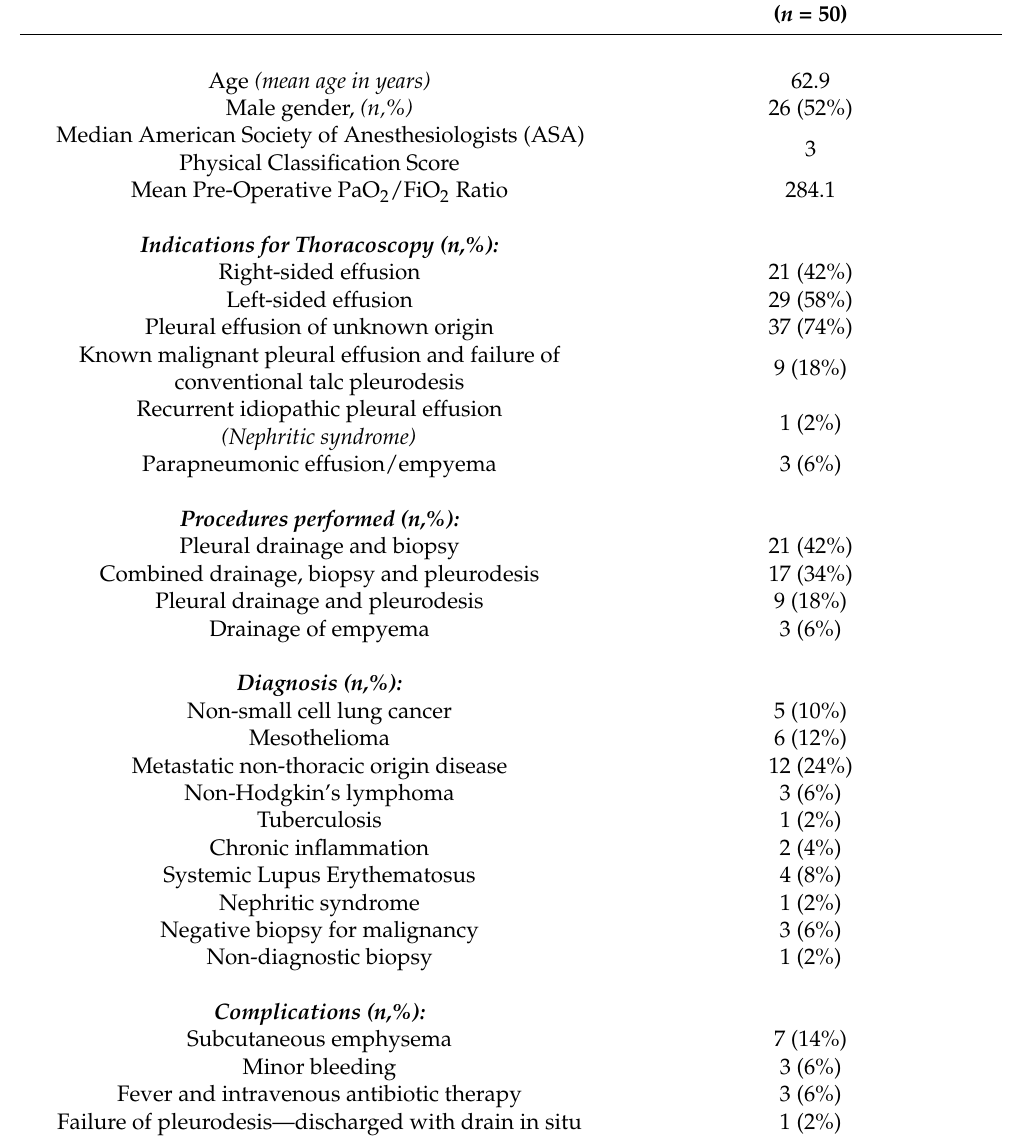
Table 1. Patient characteristics, procedures, diagnosis and